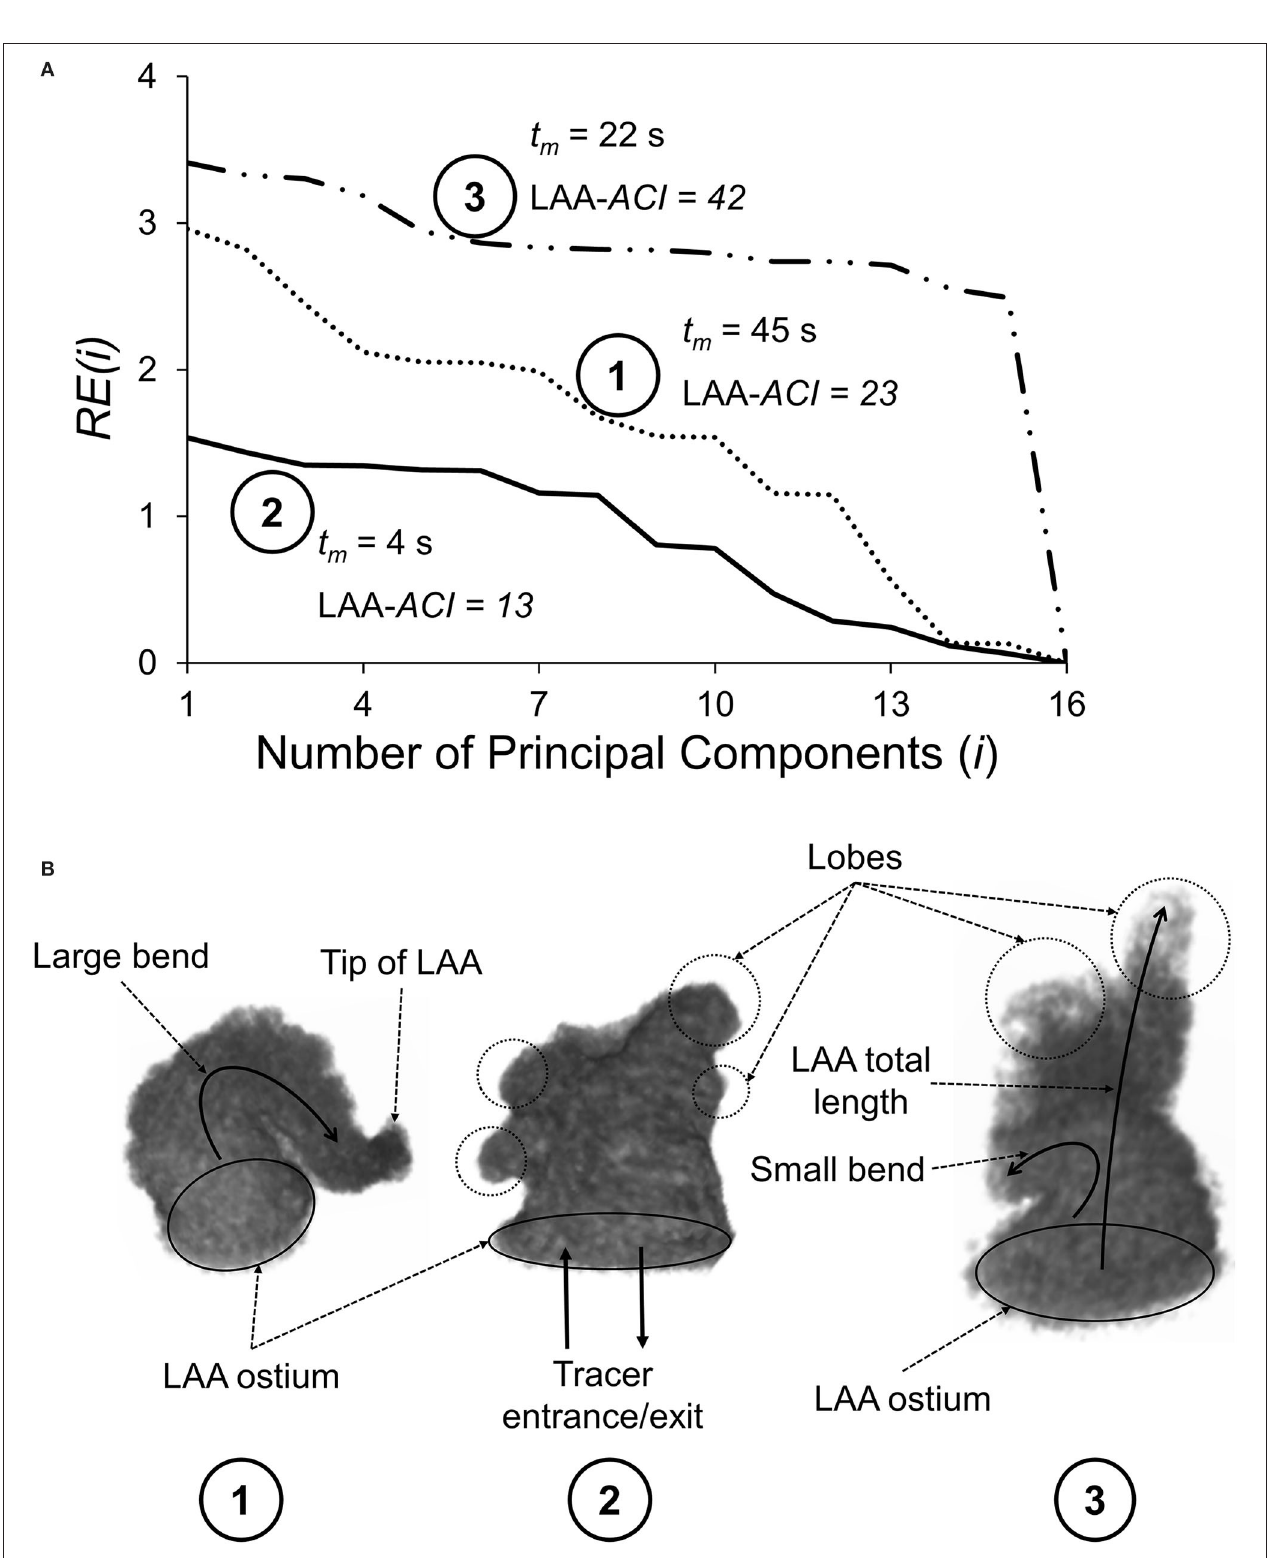
FIGURE 2 | (A) Normalized residual error, RE ( i ), plotted as a function of the number of principal components ( i ) used to reconstruct the LAA appearance for three subjects. As i increases, RE ( i ) decreases, reaching a value of zero when i = 16, corresponding to a perfect reconstruction. LAA appearance complexity index (LAA- ACI ) is defined as the area the area under the RE ( i )– i curve; larger LAA- ACI corresponds to a more complex LAA appearance. (B) Geometrical features of these three LAAs, including LAA ostium, tip of the LAA, LAA lobes (shown by circles), and LAA centerline bend (shown by curved arrows). The rank ordering of these three LAAs based on the LAA- ACI (most complex to simplest) is subject #3, subject #1, and subject #2.